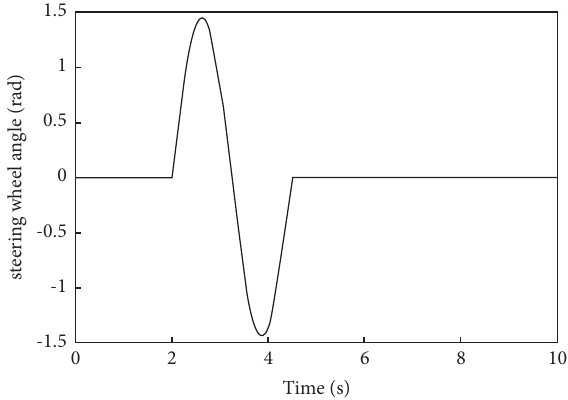
Figure 5: Sine input of steering wheel angle.